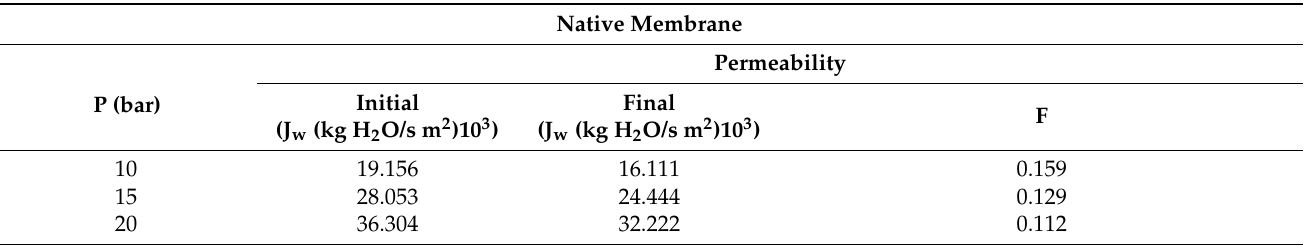
Table 4. Initial and final permeate mass flows from the permeability and selectivity tests, rejection results of the saline solutions, and fouling factor of the native